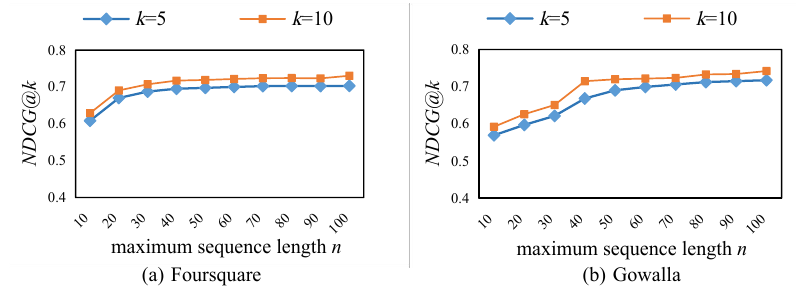
Figure 6. Effect of maximum sequence length n on recommendation performance.